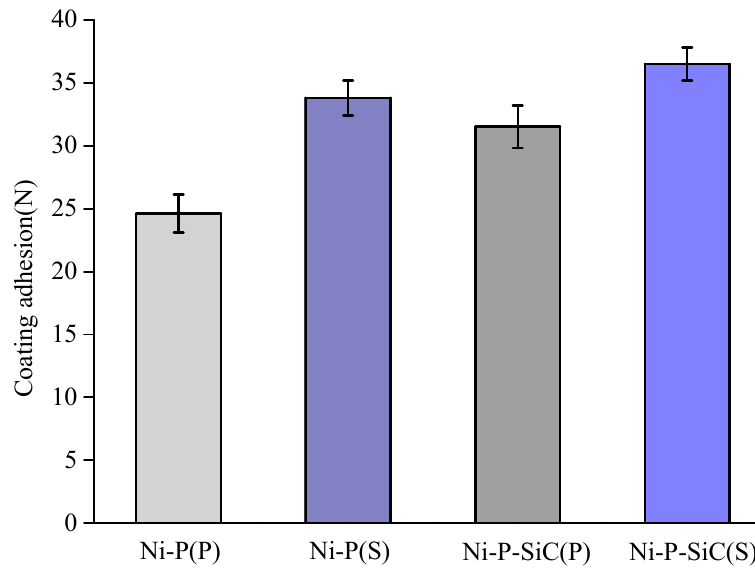
Figure 9. Adhesion of coatings prepared by scanning electrodeposition on 45 steel substrates with different pretreatment processes.